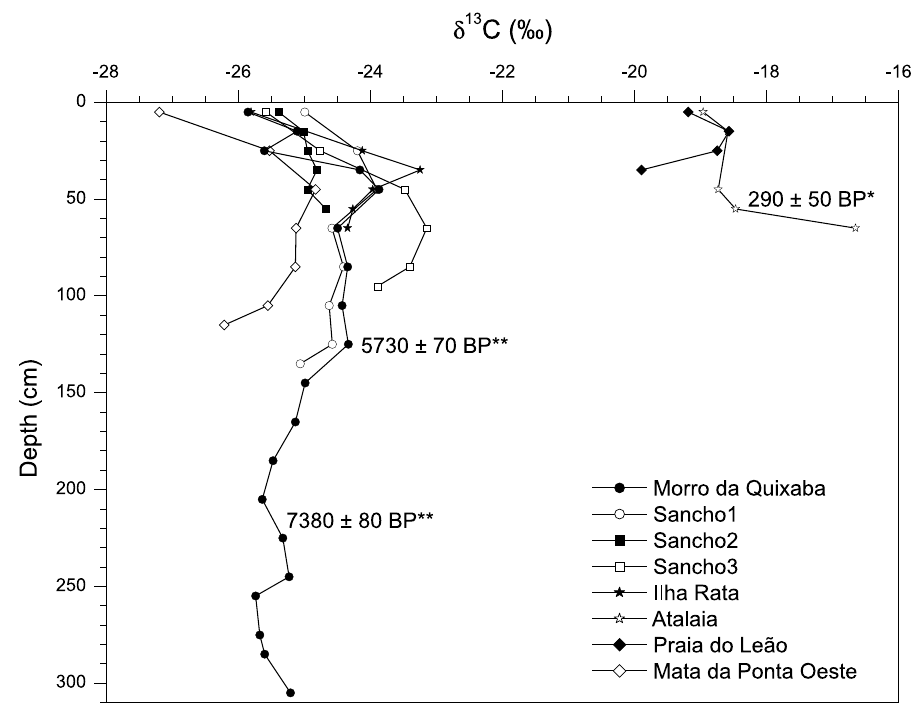
Fig. 2 – Isotopic values ( δ 13 C) in relation to soil depth collected in distinct locations at Fernando de Noronha and respective 14 C ages of charcoal fragments ( ∗ ) and humin fraction ( ∗∗ ) .